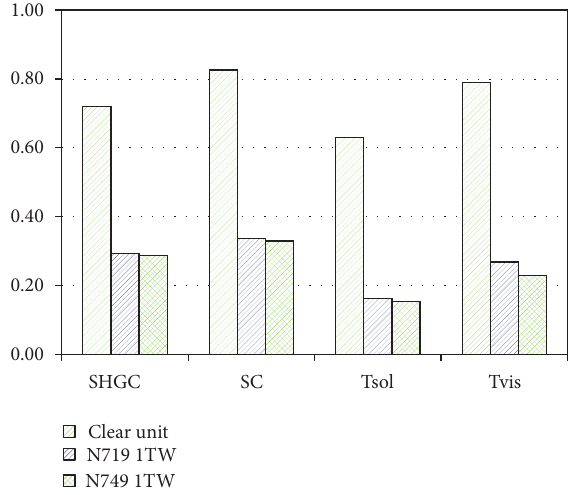
Figure 8: Performance of typical windows and DSC windows. Figure 9: Thermal performance and optical performance for N719 types of DSC windows.